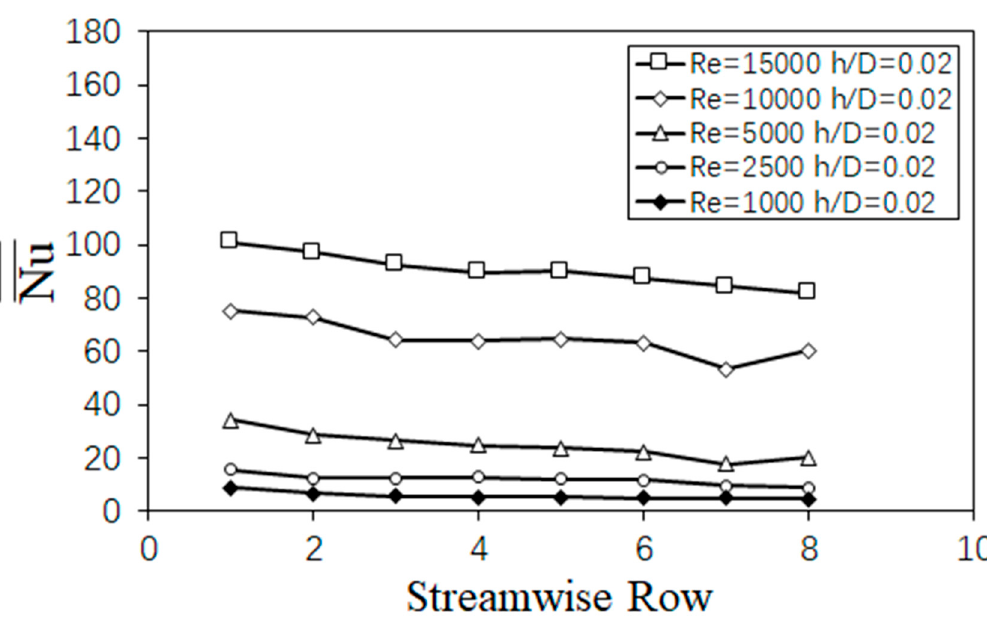
Figure 14. Spatially averaged Nusselt numbers as dependent upon streamwise row location, for different Re j , for micro cooling units height of 0.02 D.